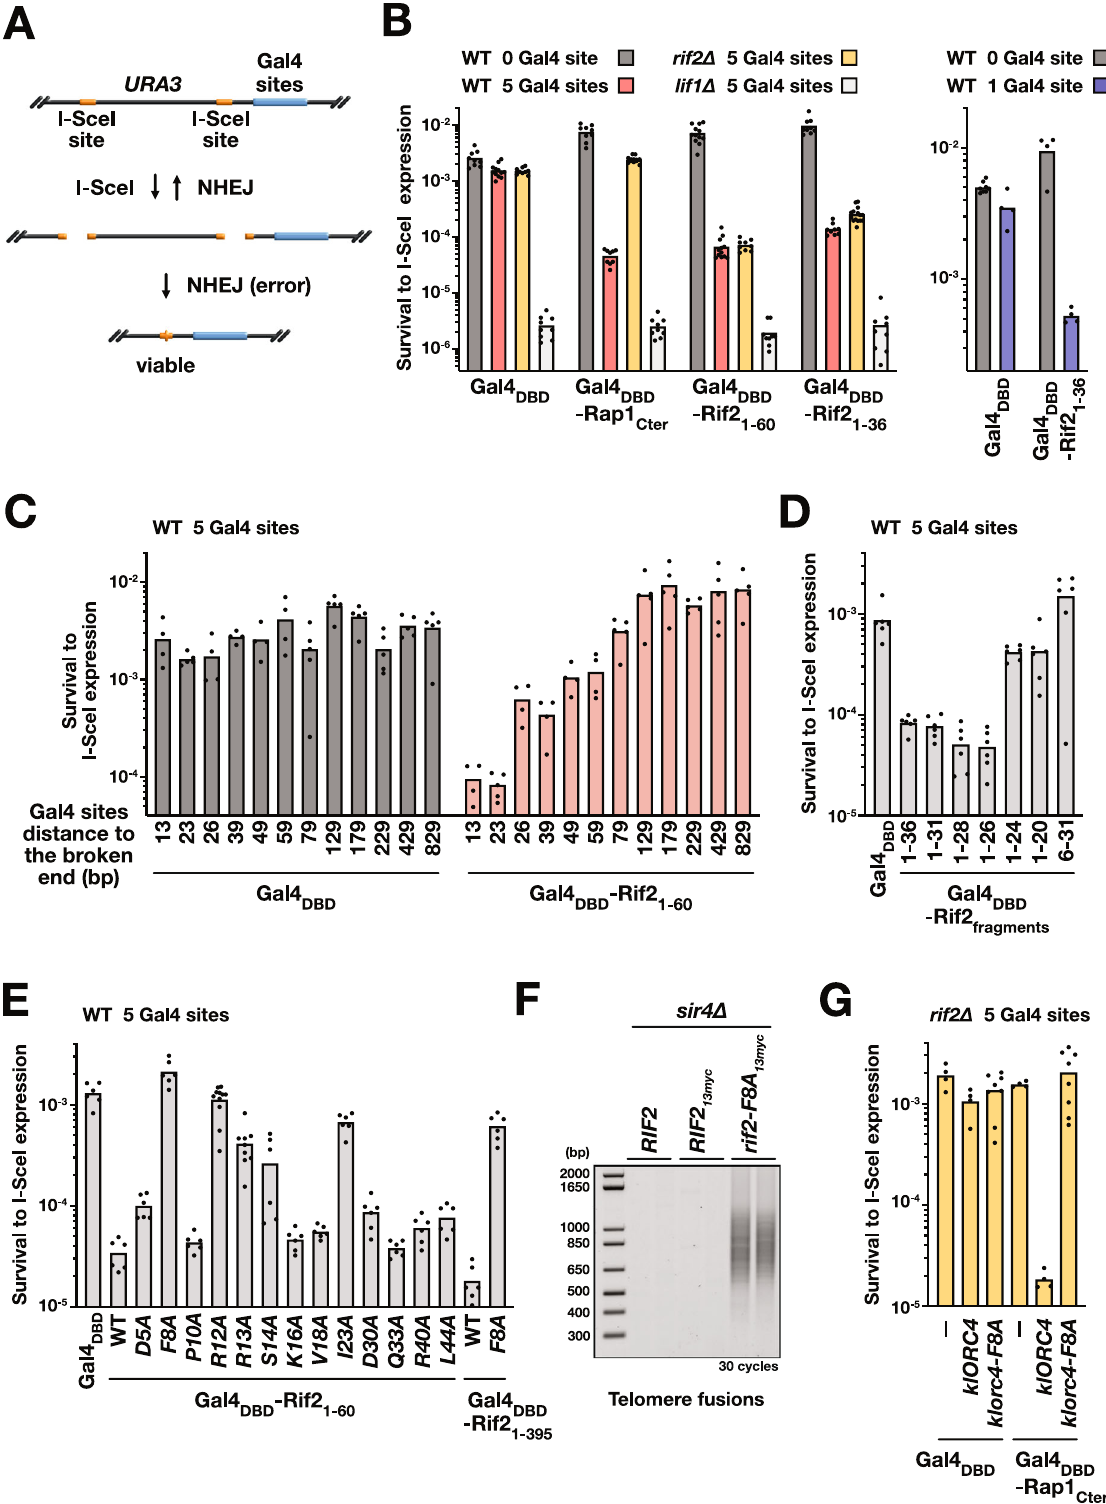
Fig. 2 Rif2 BAT motif inhibits NHEJ at broken ends. A I-SceI assay used to estimate NHEJ ef fi ciency. Two inverted I-SceI sites are inserted at the endogenous URA3 gene. Most survivors to continuous I-SceI expression have eliminated the I-SceI sites by fusing the distal broken ends 21 . B NHEJ inhibition by Rap1 C-terminal domain and Rif2 N-terminal region targeted at broken ends ( lif1 Δ : NHEJ-de fi cient cells). Means from independent cell cultures. C Increasing distances between the broken end and the Gal4 binding sites decrease NHEJ inhibition by Rif2. D Rif2 N-terminal truncations impacting the ability to inhibit NHEJ at broken ends. Gal4 DBD and Gal4 DBD -Rif2 fragments expressed from a centromeric plasmid. E Rif2 mutations impacting its ability to inhibit NHEJ at broken ends. Gal4 DBD and Gal4 DBD -Rif2 1-60 expressed from an integrated plasmid. Gal4 DBD -Rif2 1-395 expressed from a centromeric plasmid. F The rif2-F8A mutation exposes telomeres to NHEJ in cells lacking Sir4 (fusions between X and Y ′ telomeres). Experiment reproduced three times. G K. lactis Orc4 expression complements Rif2 loss for NHEJ inhibition by Rap1 C-terminal domain in S. cerevisiae . NATURE COMMUNICATIONS| (2021) 12:2763 |https://doi.org/10.1038/s41467-021-23035-w|www.nature.com/naturecommunications